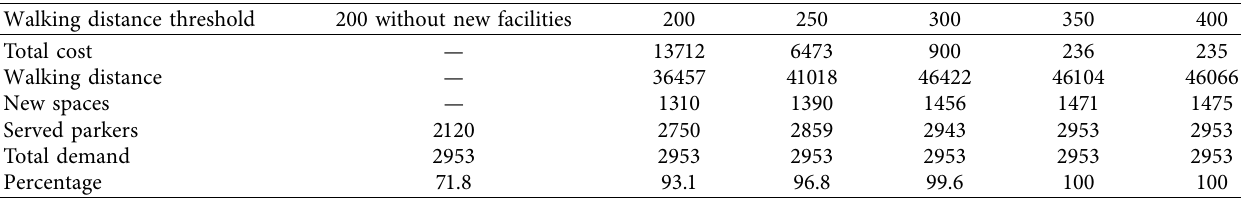
Table 2: The optimal results under different maximal walking